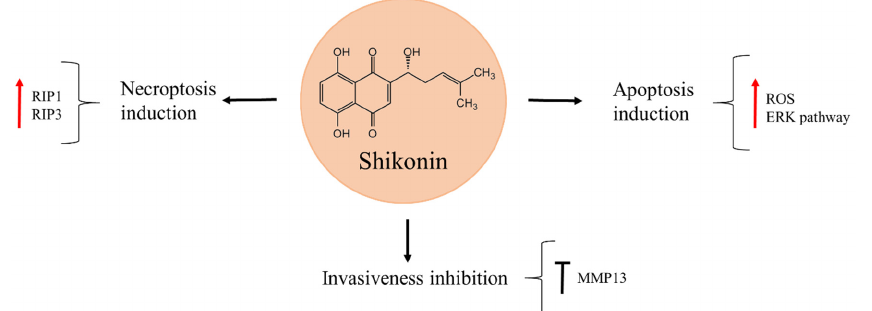
Figure 6. Shikonin in osteosarcoma inhibition.